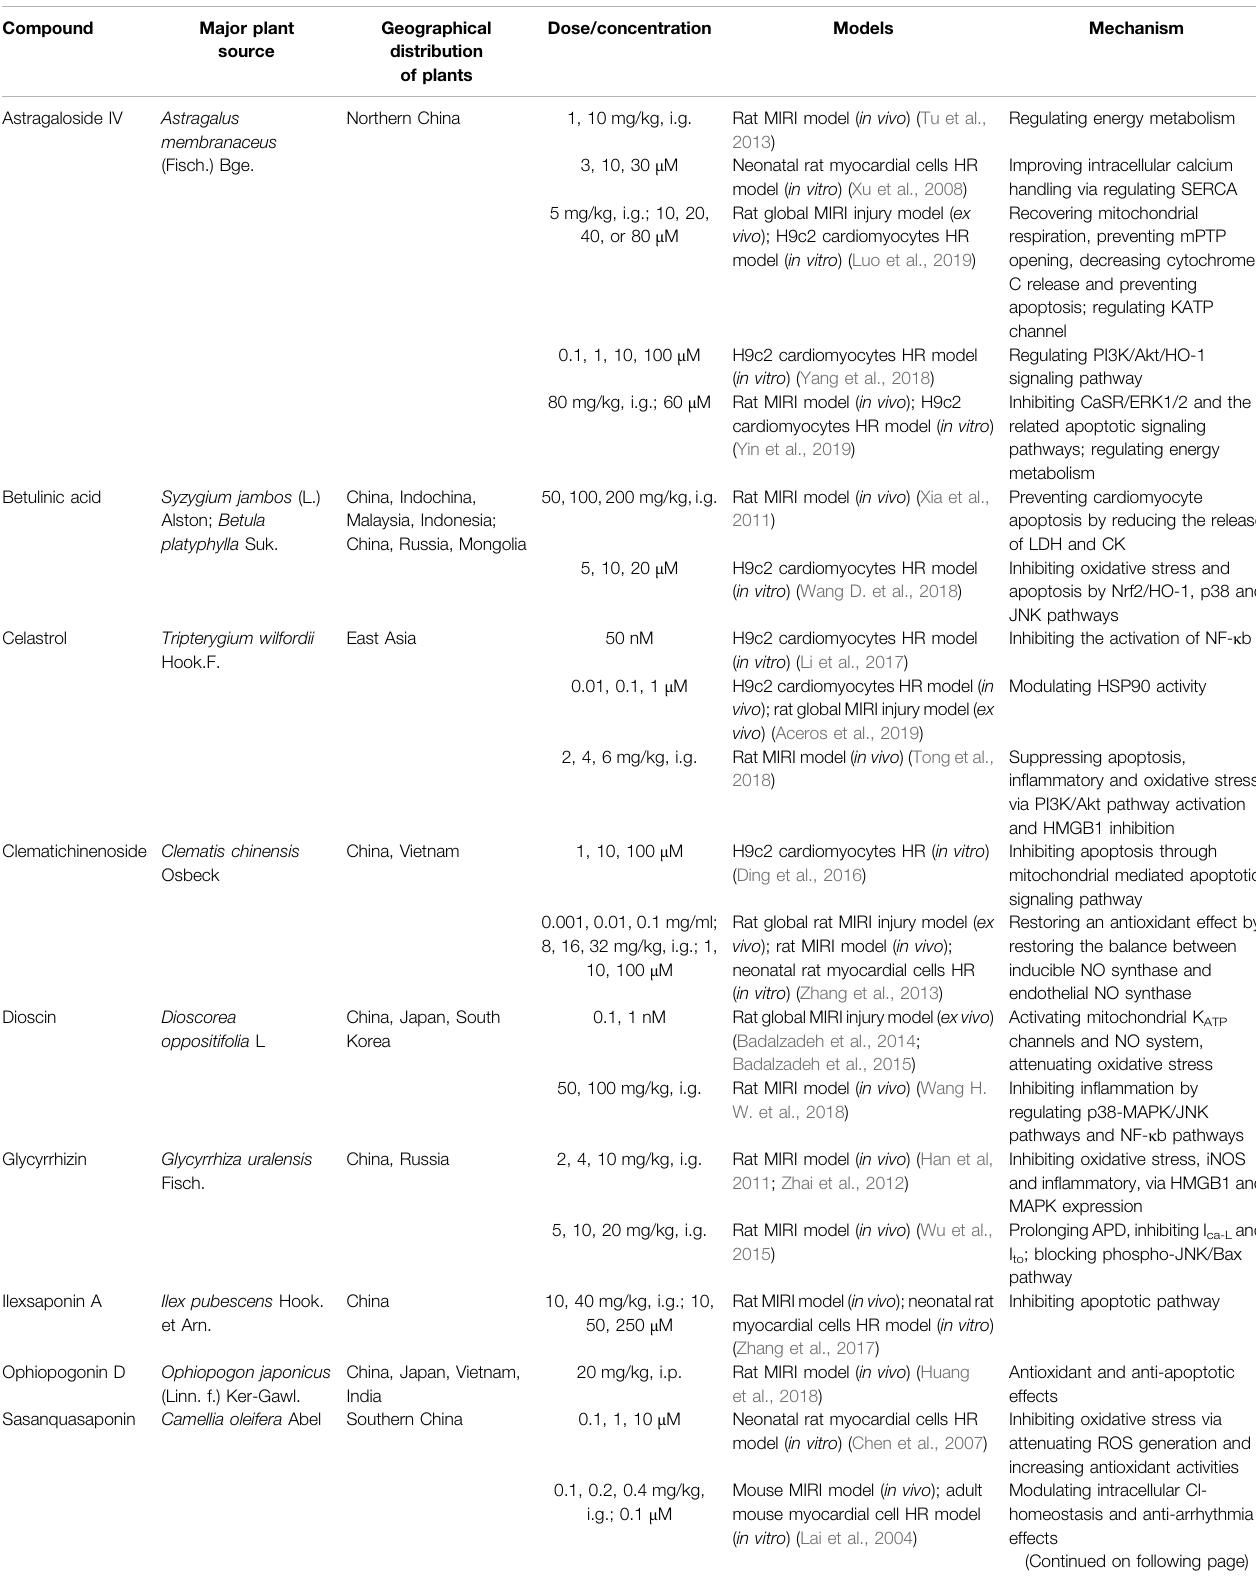
TABLE 3 | Anti-MIRI effects of other